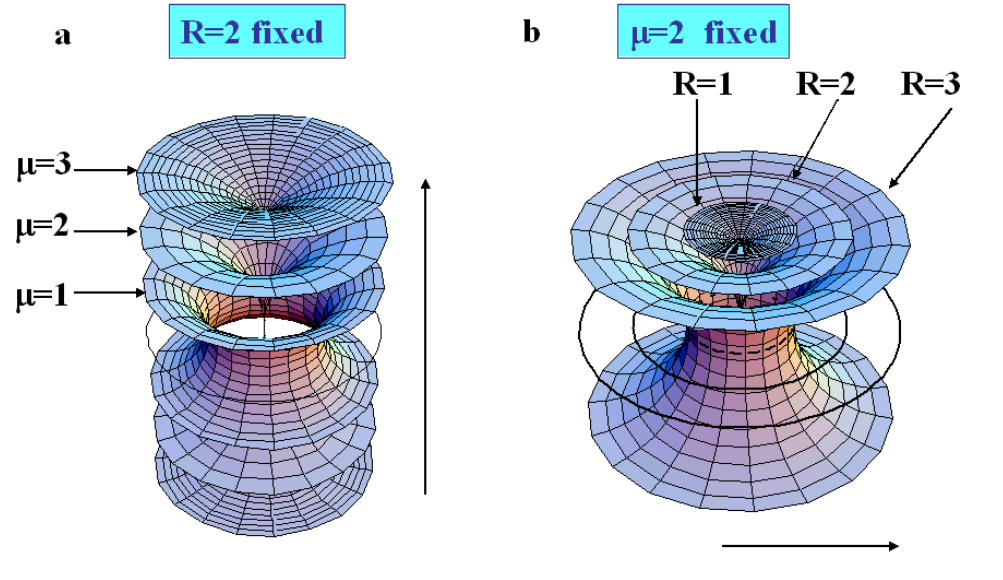
Figure 8. (a): R=2; when µ increases layers of type 2 transform into layers of type 3; (b): µ = 2 ; when R increases, layers of type 3 transform into layers of type